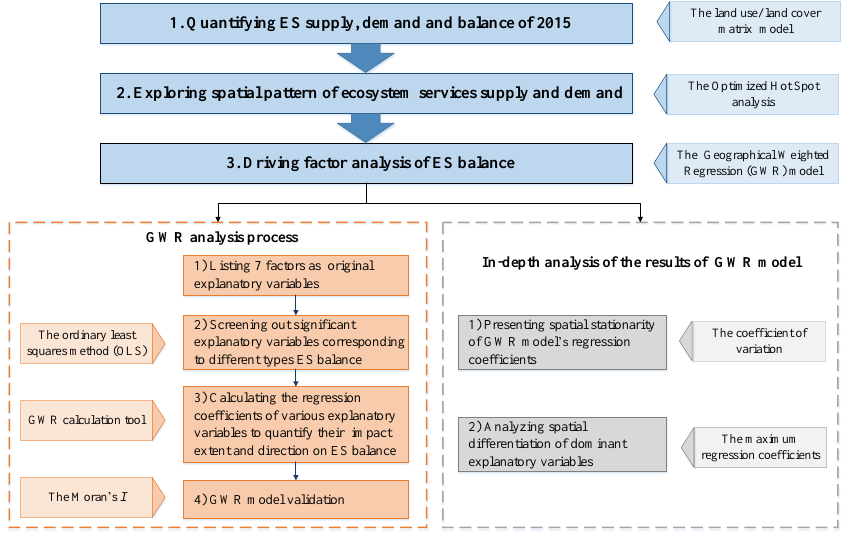
Figure 3. Research framework and corresponding methods.